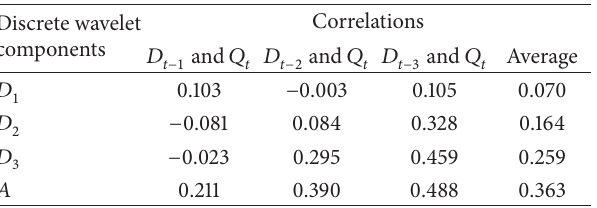
Table 1: The correlation coefficients between subtime series